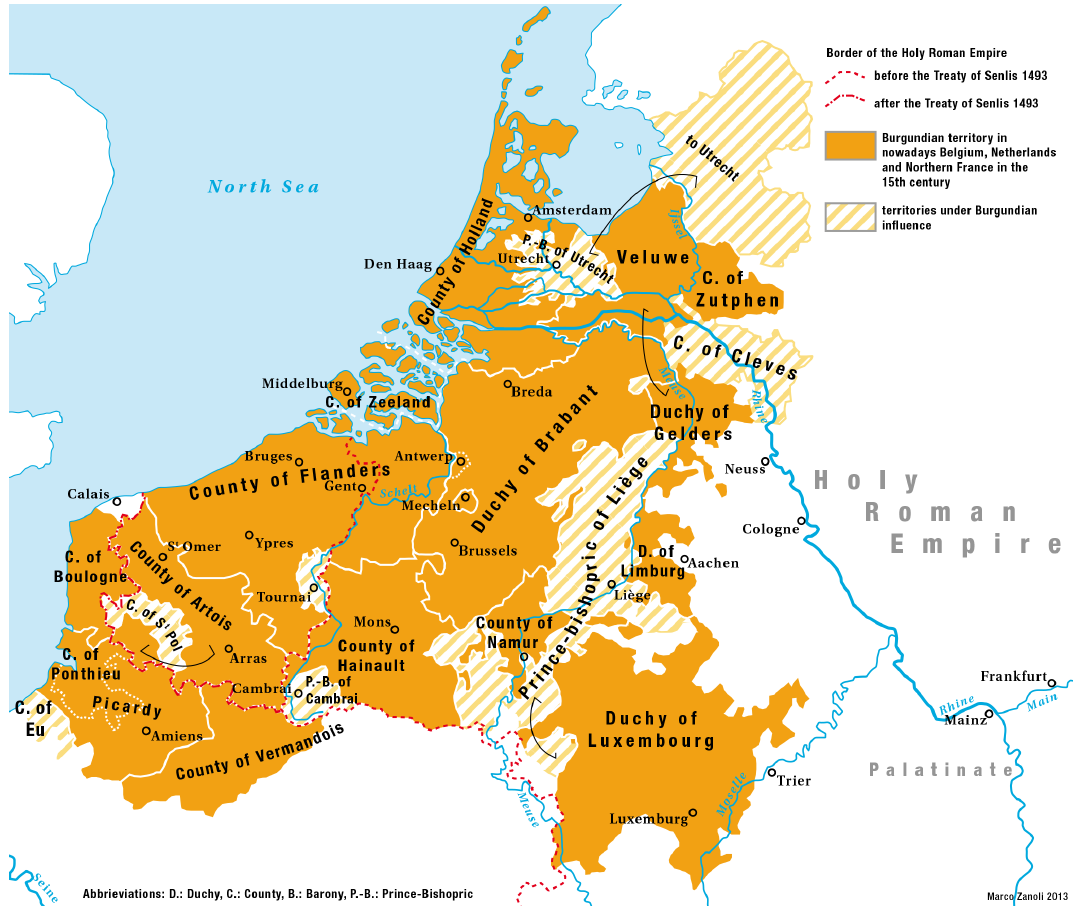
Figure 1. The Burgundian Low Countries (map from Marco